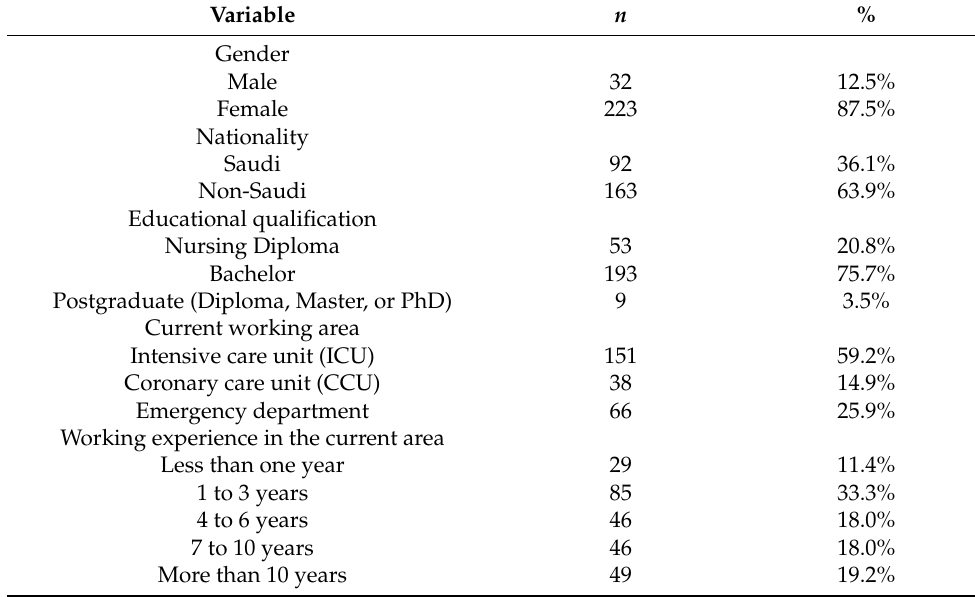
Table 2. Sociodemographic of the study